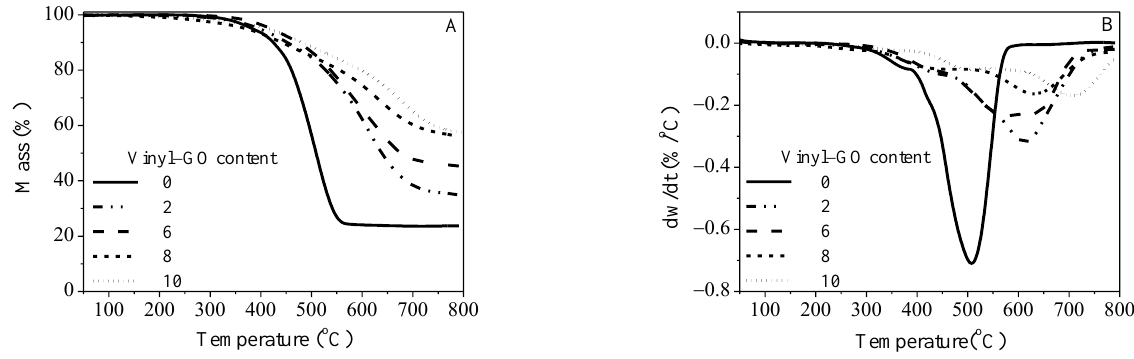
Figure 5. TG curves ( A ) and DTG curves ( B ) of neat SR and SR/vinyl-GO nanocomposites.